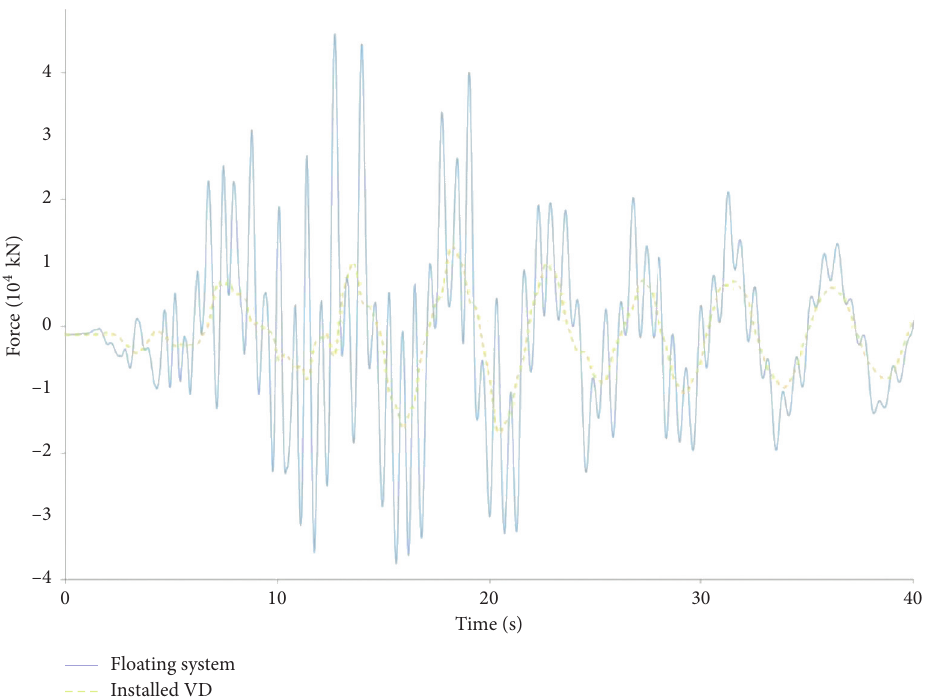
Figure 13: Time history analysis of the VD damping force and the tower base shear.